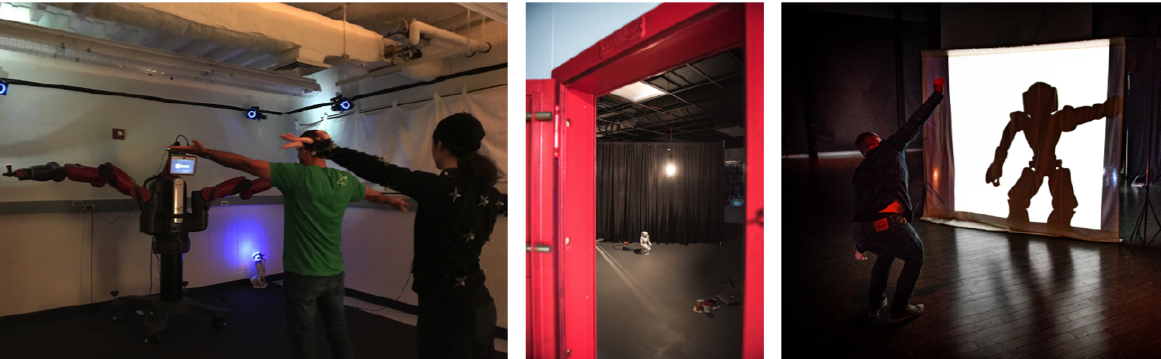
Figure 1: Images showing the themes of the Time to Compile installation. On the left during an early instantiation of the installation: a par- ticipant in a green shirt follows the movement of the Baxter, unaware that they are being followed by a human performer in a motion cap- ture suit behind them, illuminating the theme of human involvement inside technology and robot-like interpretations. In the center: a NAO robot while booting, viewed through the portal of a red door, showing the voyeurism of ubiquitous cameras as well as machine compile times. On the right: a large projection screen broadcasts a scaled-up shadow of the NAO robot, illuminating the hidden network nature of many